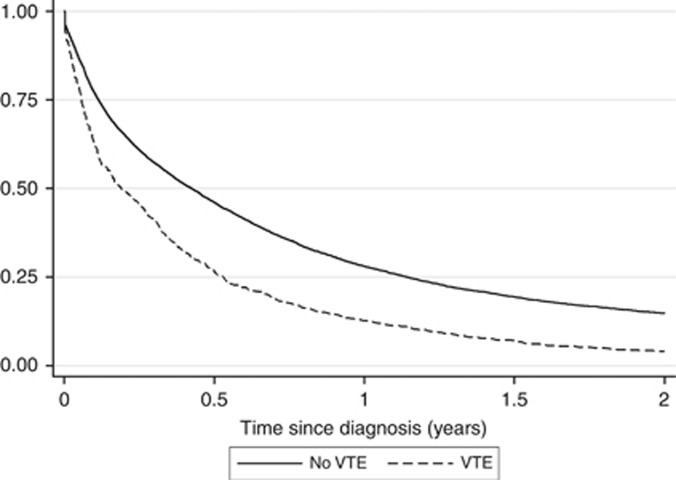
Survival of lung cancer patients according to diagnosis of VTE. To reduce the effect of immortal time bias, VTE was defined in a time-varying manner, whereby patients start in the ‘no VTE' group, and are switched to the ‘VTE' group after VTE diagnosis.